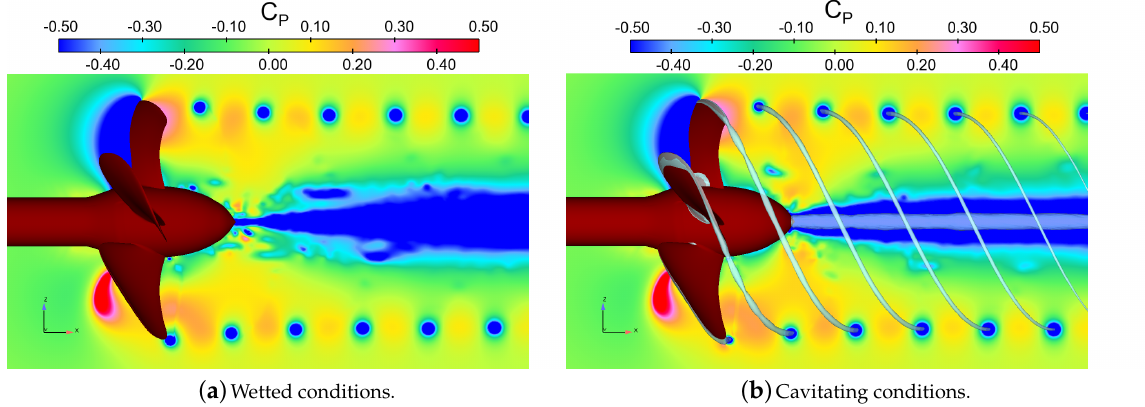
Figure 15. Distribution of the pressure coefficient near the propeller on the cut plane y = 0. In the cavitating case, the iso-surface of the void fraction α = 0.1 is coloured light